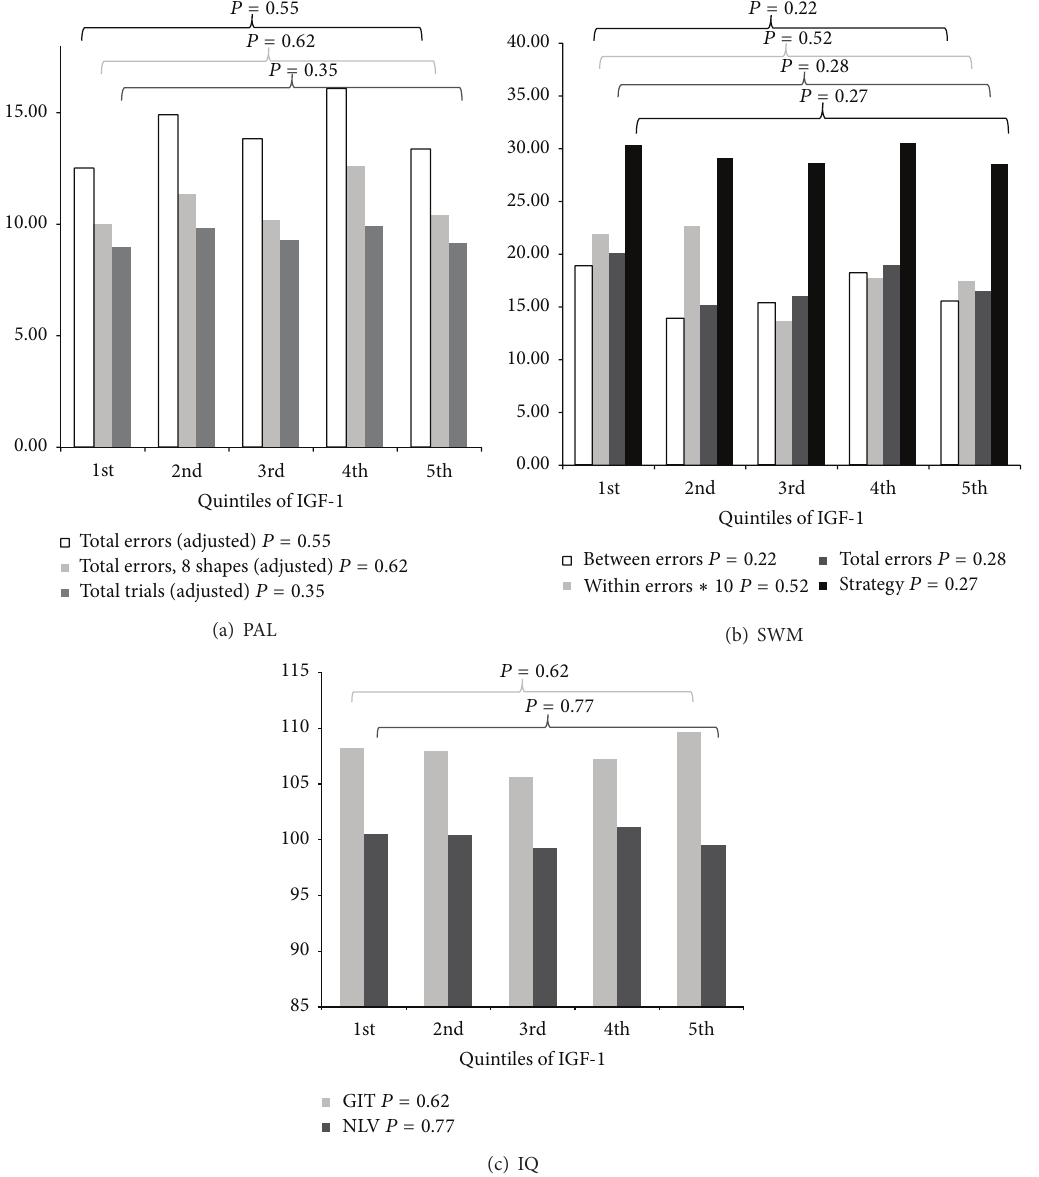
Figure 1: Mean adjusted ∗ cognitive scores per quintile of IGF-1 serum level. Quintiles of IGF-1 were made for men and women separately and merged afterwards. 𝑃 values represent overall 𝑃 values based on ANOVA statistics for the comparison of the GIT and NLV between quintiles of IGF-1 and MANOVA statistics for the comparison of PAL and SWM scores between quintiles of IGF-1. ∗ Adjusted for age, gender, and BMI.